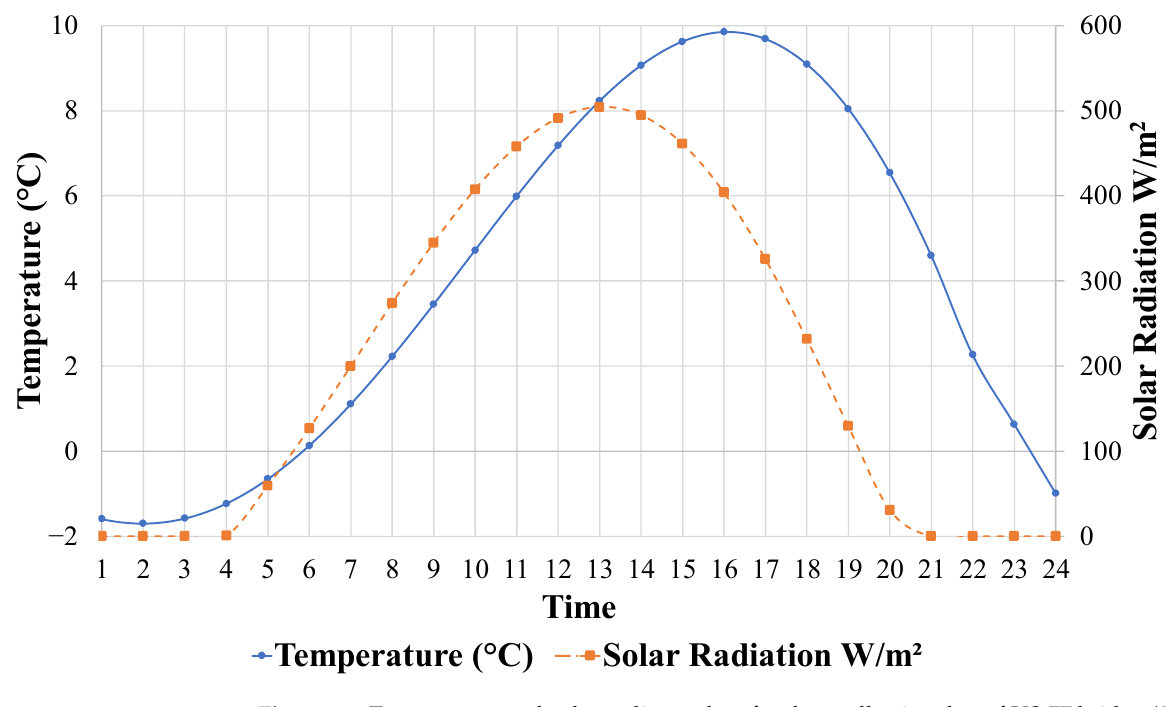
Figure 10. Temperature and solar radiance data for data collection day of US-77 bridge (9 March 2018) Lincoln, Nebraska [69].